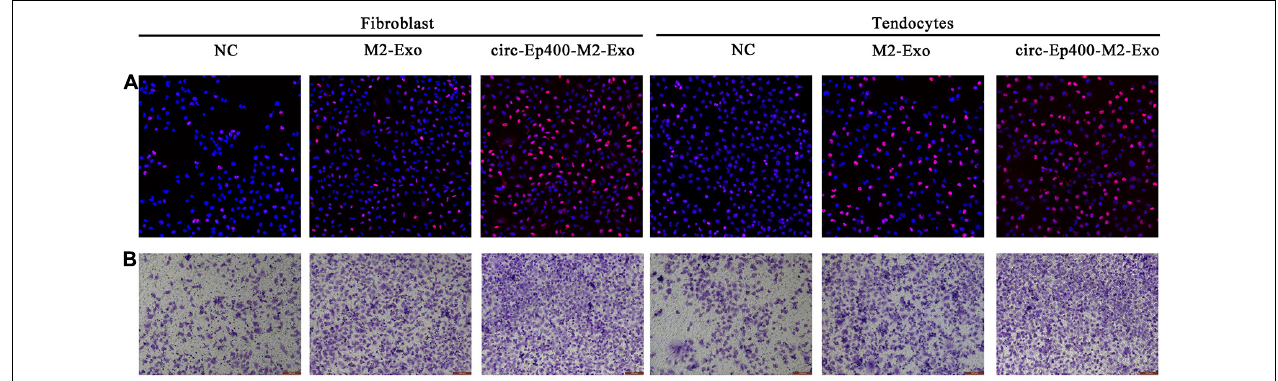
FIGURE 6 | M2 macrophage-derived circRNA-Ep400-containing exosomes promote proliferation and migration of fibroblasts and tenocytes in vitro . (A) The 5-ethynyl-2’-deoxyuridine assay showing the proliferative ability of both fibroblasts and tenocytes. (B) Transwell assays show the migration ability of both fibroblasts and